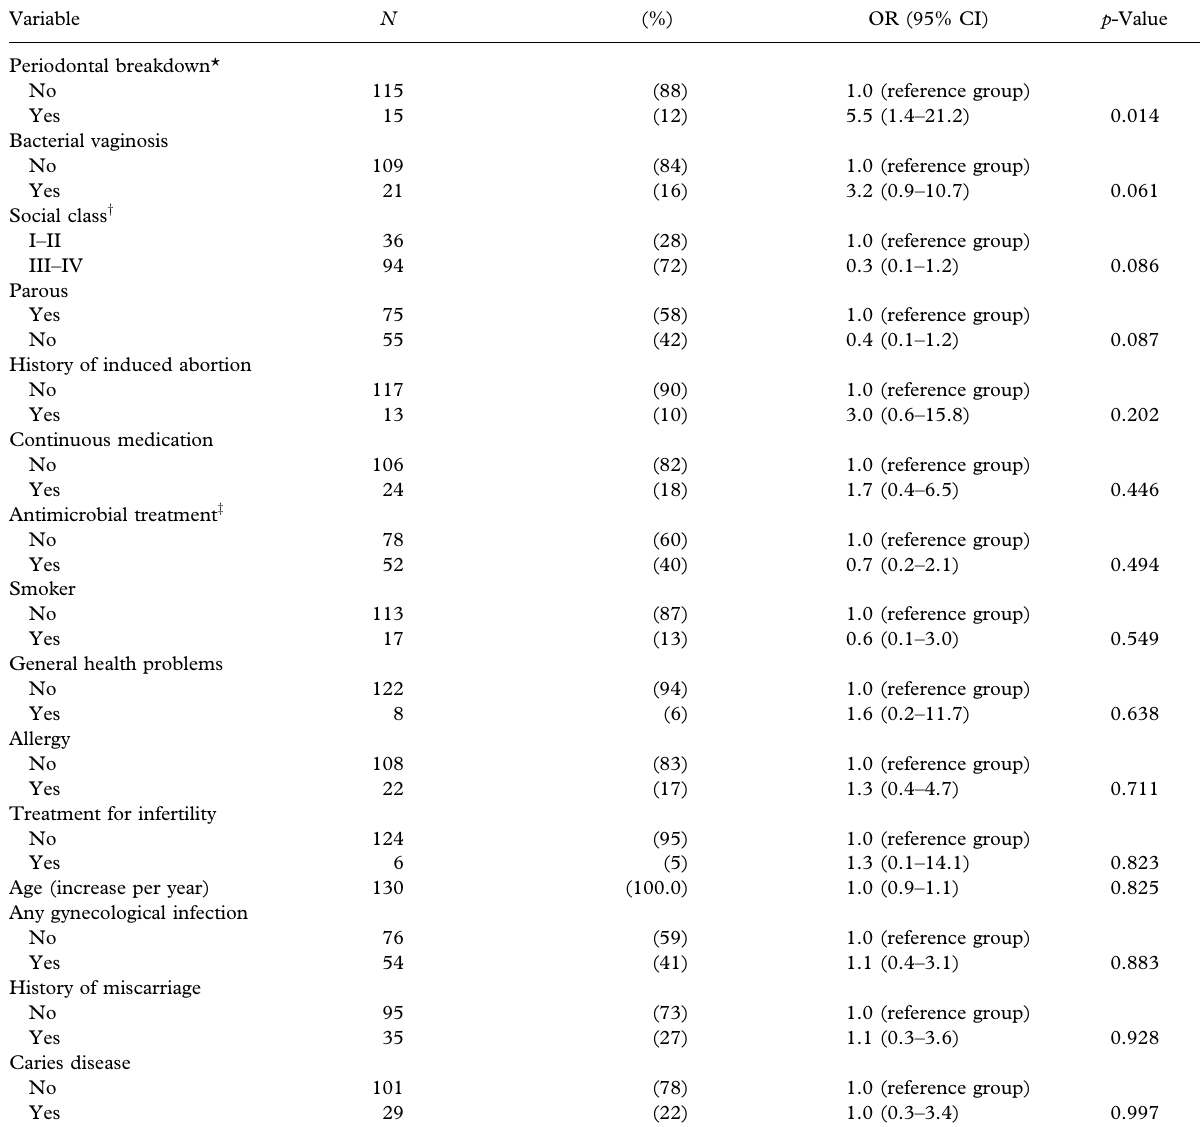
Table I. Multivariate analysis of risk factors for adverse pregnancy outcome in women planning